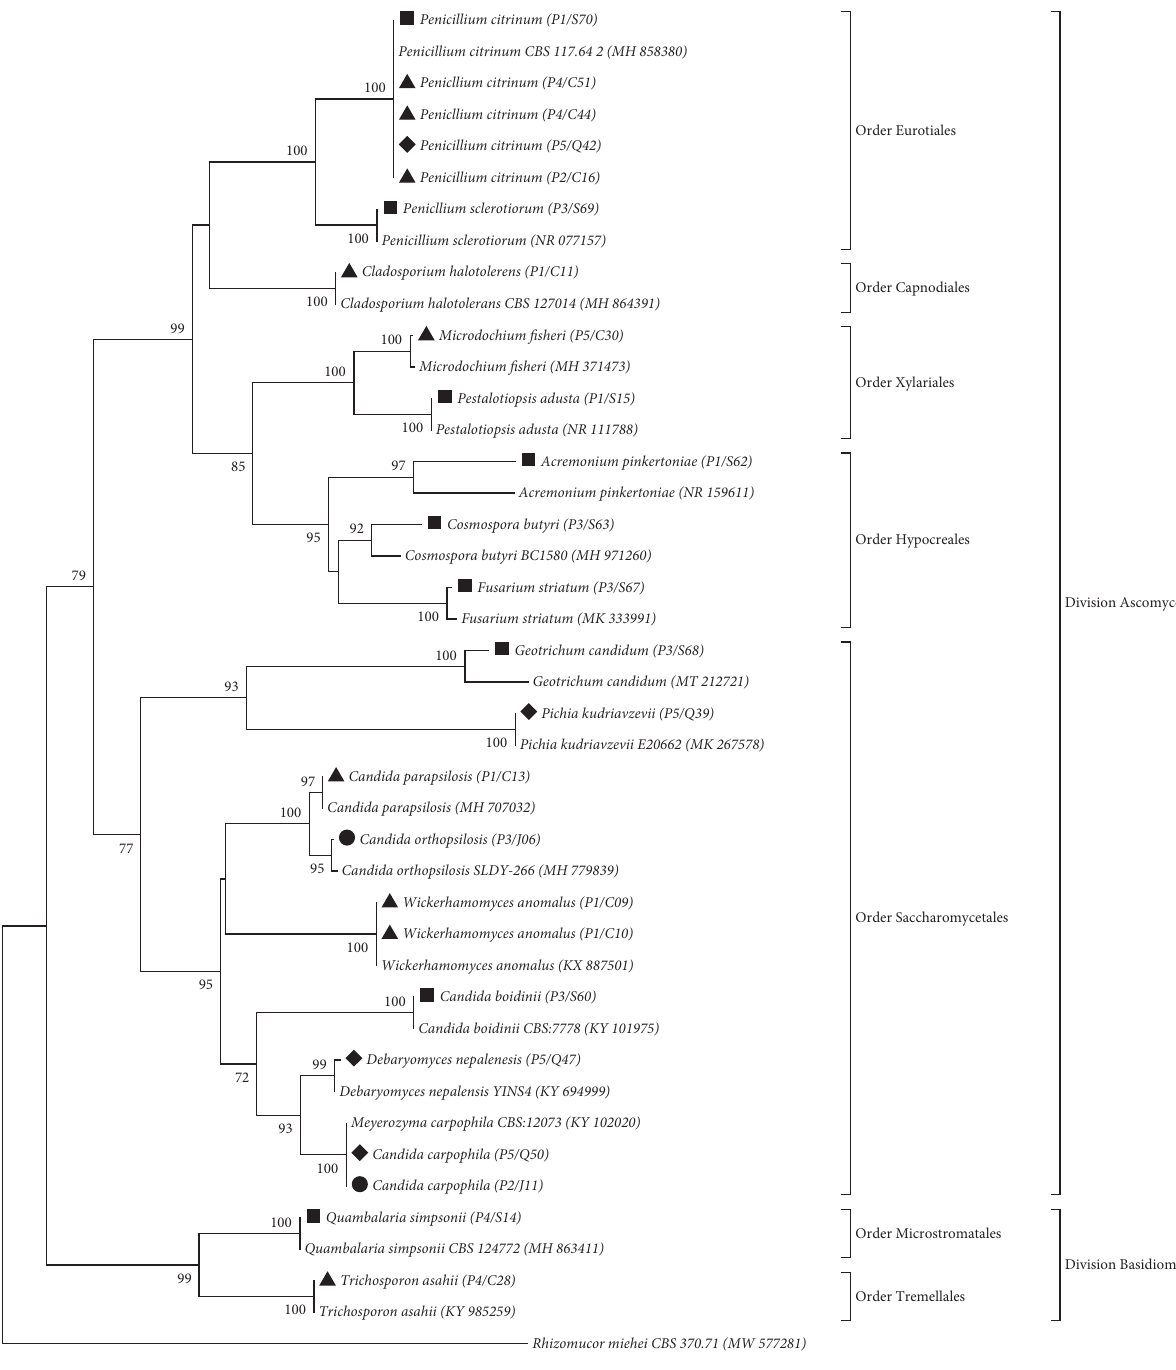
Figure 5: Phylogenetic tree of fungi (yeasts and moulds) isolated from king coconut water processing facilities based on their ITS1 and ITS2 gene sequences. The strains isolated in this study are given in bold italics with isolation point and isolate ID. Each symbol denoted the following: ● Facility I (JA), ■ Facility II (SM), ▲ Facility III (CW), and ◆ quality-defected samples, respectively. The tree was constructed using the neighbor-joining method with MEGA 7. The percentages of bootstrap values for 1000 replicates are indicated at the branching point. The scale bar indicates changes per